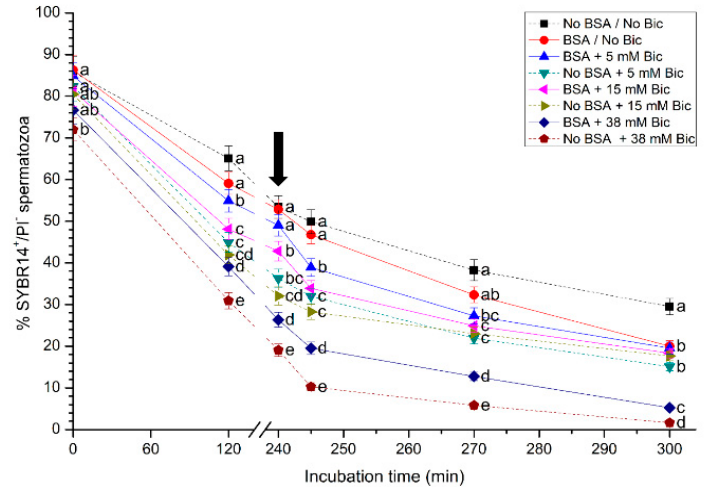
Figure 1. Percentages of sperm with an intact plasma membrane (SYBR14 + /PI − ) following incubation with different concentrations of bicarbonate (Bic; 0 mM, 5 mM, 15 mM, 38 mM) and BSA (0, 5 mg/mL) for 300 min. The black arrow indicates the time at which 10 µ g/mL of progesterone was added (i.e., 240 min) to induce acrosome exocytosis. Different superscripts (a–e) indicate significant differences ( p < 0.05) between treatments within the same time point. Data are shown as mean ± SEM for 12 independent experiments.